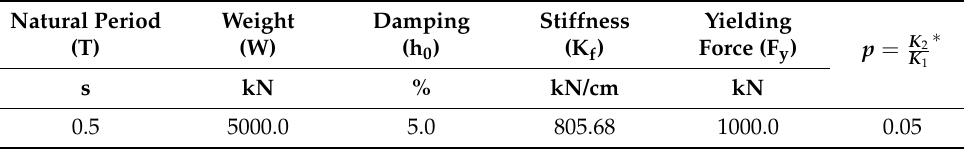
Figure 3. ( a ) The equivalent oil damper configuration in the ESDOF system; ( b ) the initial demand curve (5% damping) and capacity curve of the ESDOF system. Table 1. Technical parameters of the equivalent single degree of freedom (ESDOF) system.